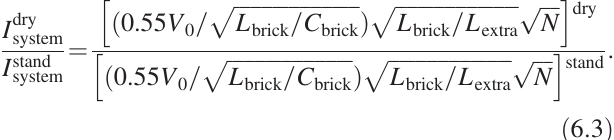
ffiffiffiffiffiffiffiffiffiffiffiffiffiffiffiffiffiffiffiffiffiffiffi L brick